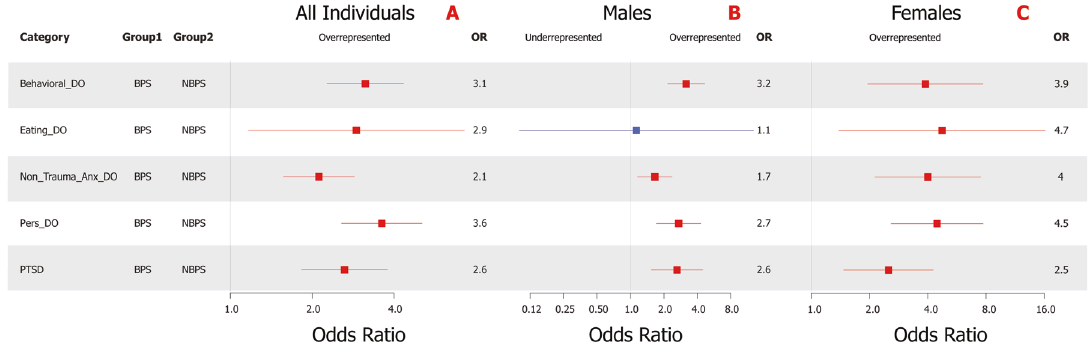
Fig. 2 BPS versus NBPS clinical category analysis results. Forest plot distribution of corrected odds ratios of the suicide-only clinical category comparisons (with 95% con fi dence interval represented by whiskers) within all subjects ( A ), male subjects ( B ), and female subjects ( C ). Labeling of comparison groups is as follows: BPS = individuals with bipolar disorder who died by suicide and NBPS = individuals without a diagnosis of bipolar disorder who died from suicide. Signi fi cant results are colored with overrepresentation shown in red and underrepresentation in green. Non-signi fi cant results are shown in blue. Results were corrected for multiple testing via the Benjamini – Hochberg method with an FDR of 0.05 for a total of 5 tests in the primary analysis ( A ) and 10 in the sex-speci fi c analyses ( B , C ) and for critical